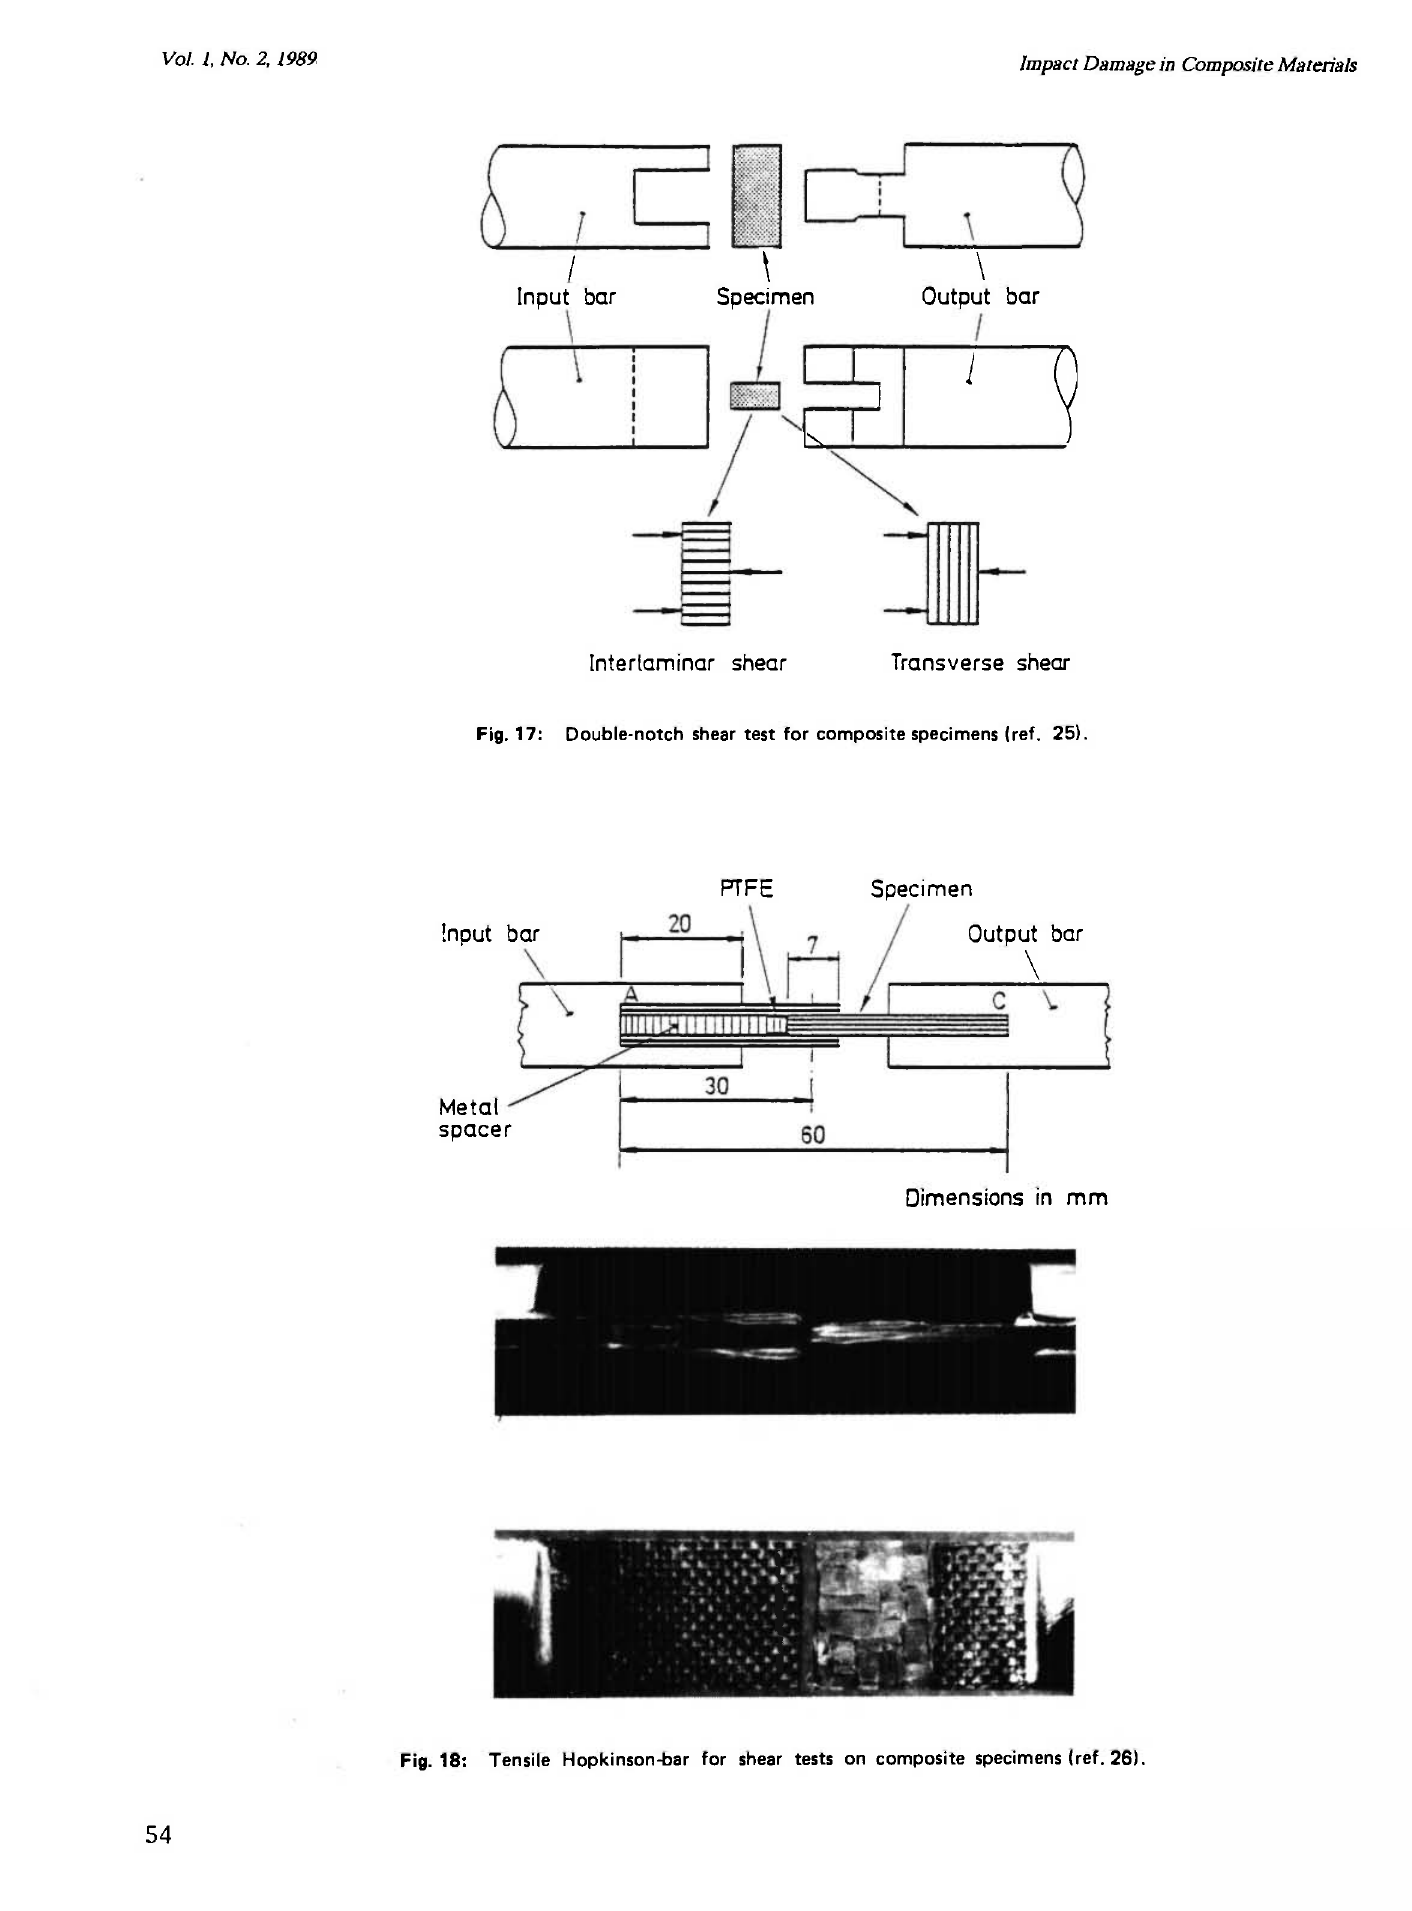
Fig. 18: Tensile Hopkinson-bar for shear tests on composite specimens (ref.